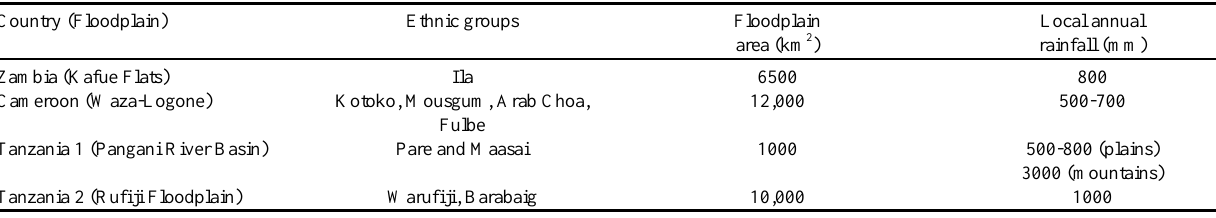
Table 1 . Basic characteristics of the chosen African floodplains Country